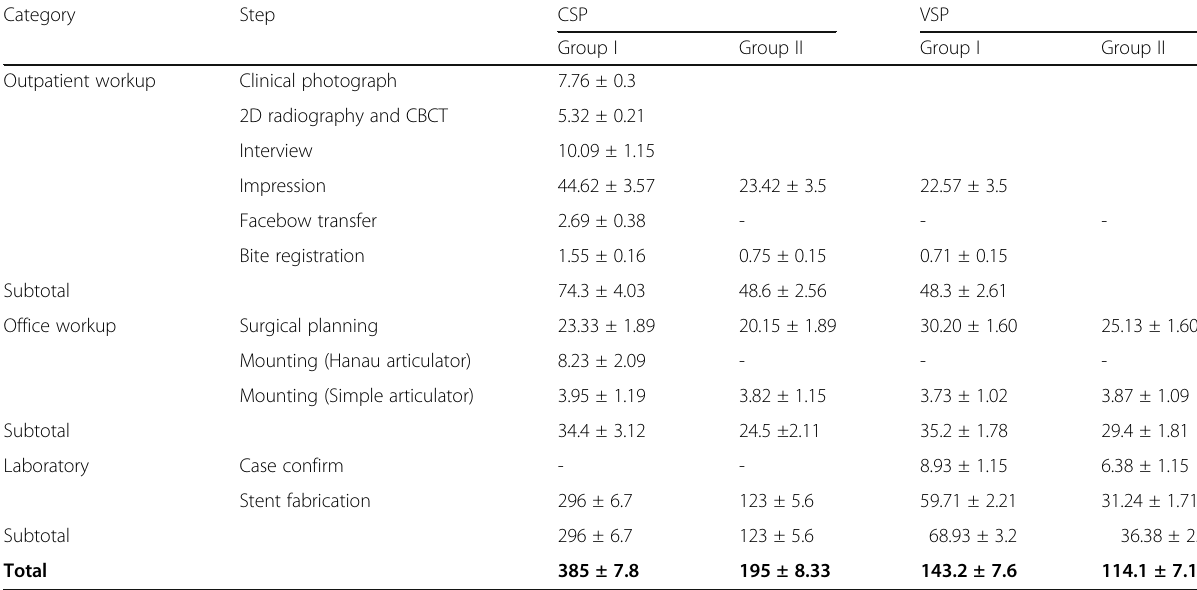
Table 2 Average time for each step in CSP and VSP Category Step CSP